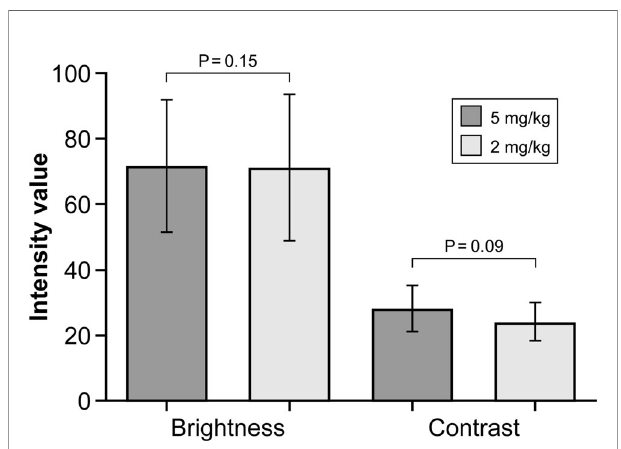
FIGURE 3 | Bar plot showing mean (SD) intensity modalities for confocal laser endomicroscopy images acquired after a fl uorescein sodium dose of 5 mg/kg or 2 mg/kg. Whisker bars indicate the SD. The values are reported in units of optical density de fi ned by Fiji open-source analytic software. Brightness is the mean gray value, calculated by the sum of the gray values of all the pixels in the selection divided by the number of pixels, and contrast is the SD of gray values used to generate the mean. Used with permission from Barrow Neurological Institute, Phoenix,